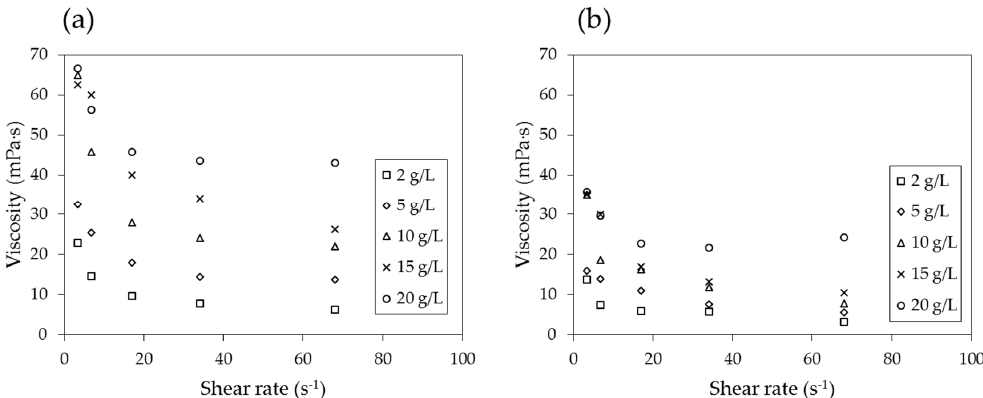
Figure 10. Viscosity with respect to shear rate at temperatures of ( a ) 25 °C and ( b ) 90 °C.